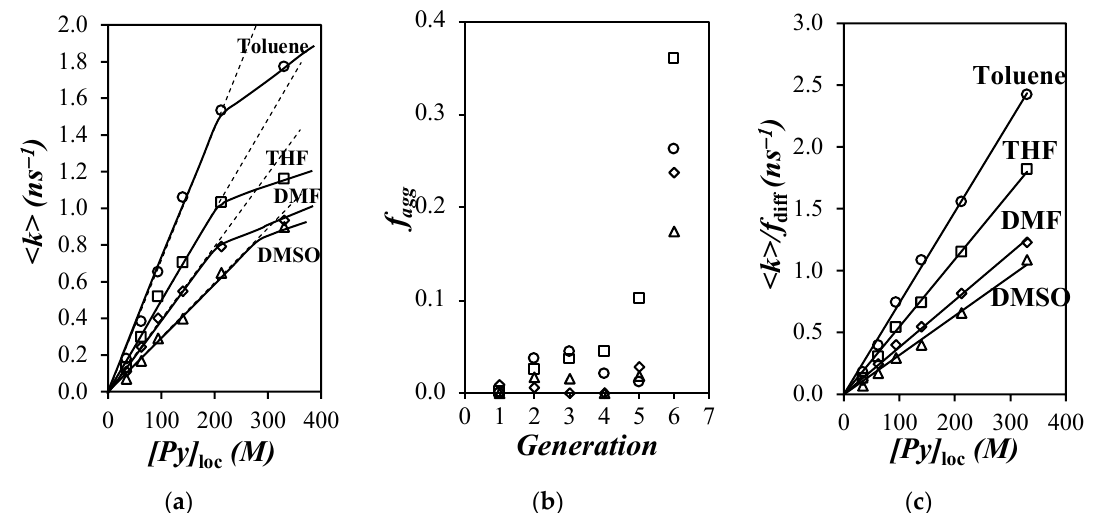
Figure 4. Plot of ( a ) < k > versus [ Py ] loc for the Py x -G( N ) dendrons, ( b ) f agg calculated by the model-free analysis (MFA) for each generation, and ( c ) < k >/ f diff versus [ Py ] loc for the Py x -G( N ) dendrons in ( ) toluene, ( ) THF [29], ( ) DMF, and ( ) DMSO.